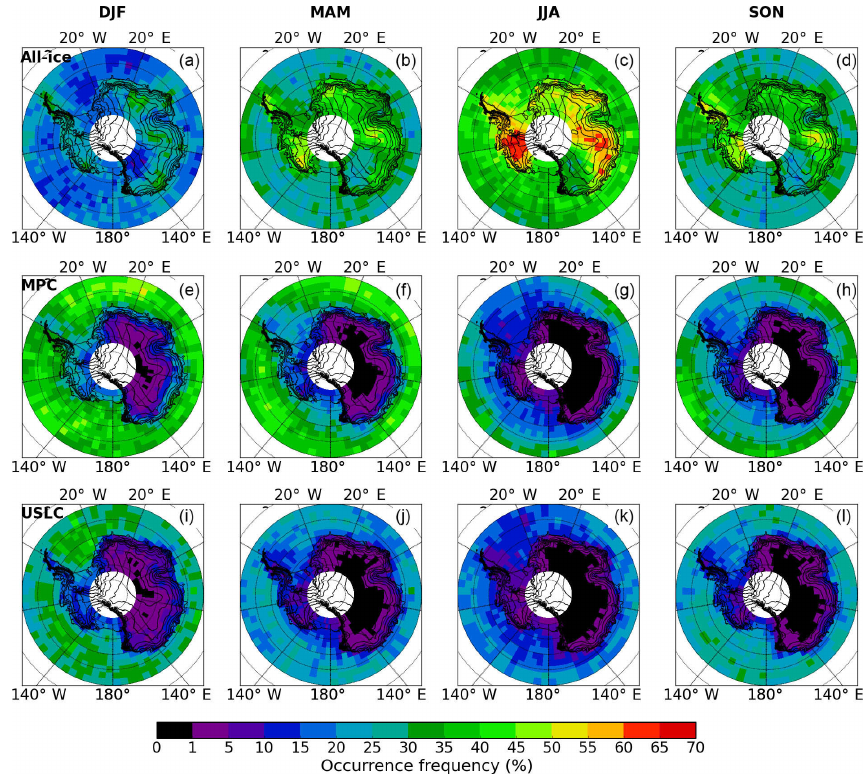
Figure 6. Geographical distribution of the total all-ice cloud fraction (a–d) , MPC fraction (e–h) and USLC fraction (i–l) for each of the four seasons based on 2007–2010